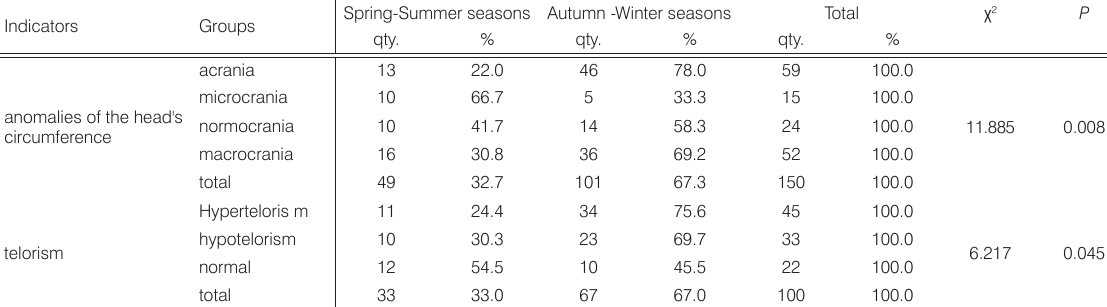
Table 4. Relationships between the seasons of conception and associated abnormalities in fetuses with NTDs.